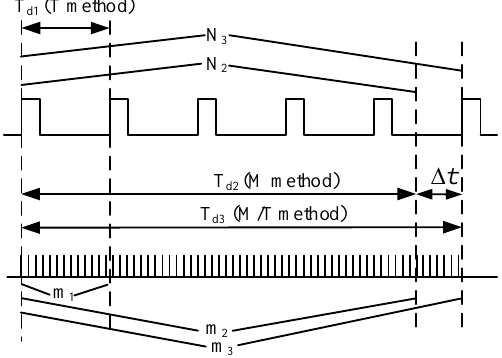
Figure 5. Principles of T , M , and M/T methods.